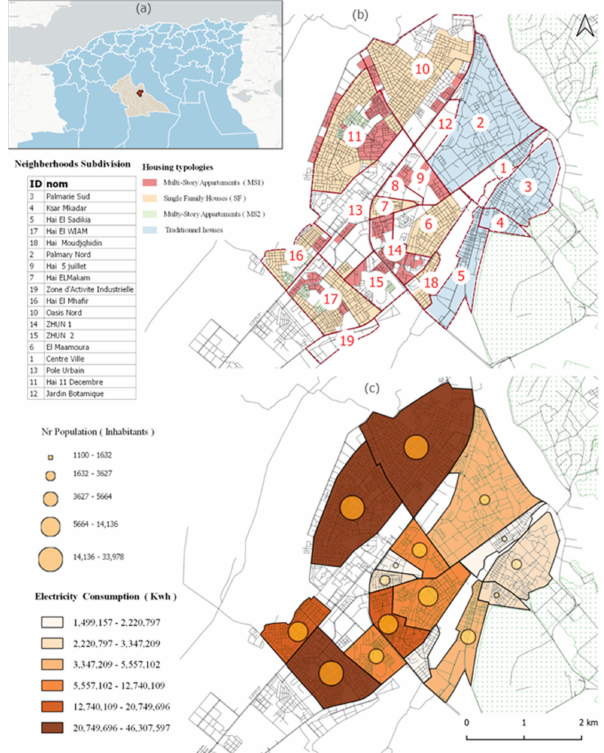
Figure 3. ( a ) The geographical location of Laghouat Province. ( b ) Neighborhoods’ subdivision in the municipality of Laghouat. ( c ) Population and residential Electricity consumption in the